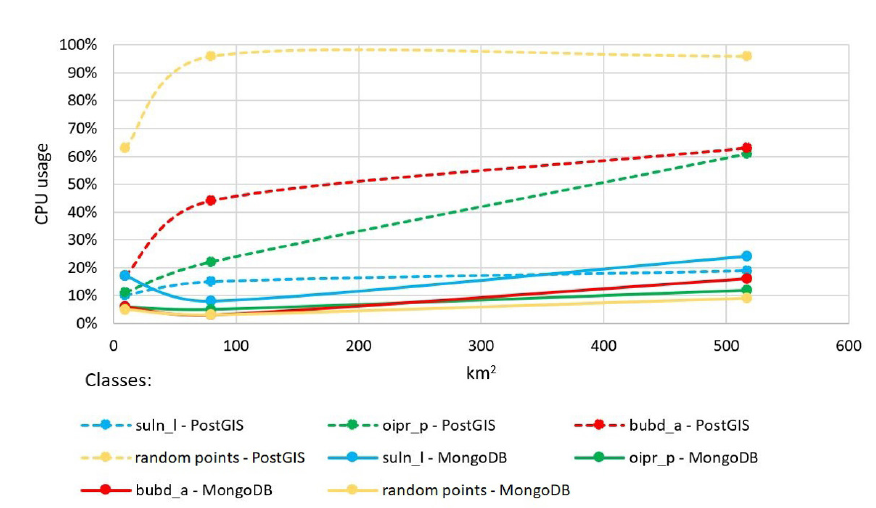
Fig. 3. The CPU usage of query in dependence of the size of the search area for the Intersects operator